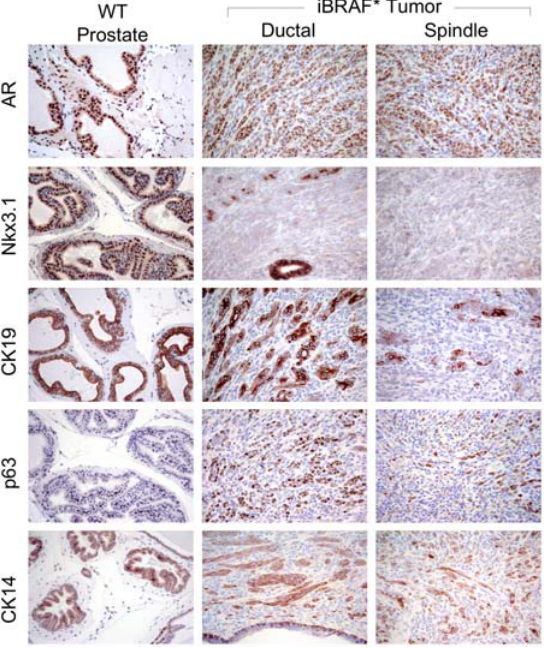
Figure 3. iBRAF* prostate tumors exhibit epithelial lineage markers. Both ductal and spindled components of iBRAF* prostate tumors express epithelial lineage markers: CK14 and p63 for basal cell, AR and Nkx3.1 for luminal cell, and CK19 for transit-amplifying